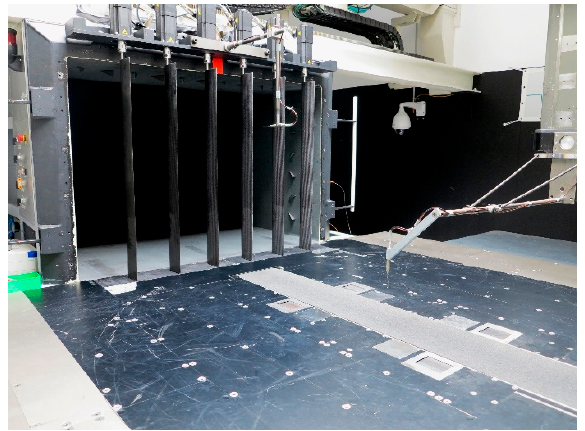
Figure 1. Forschungsinstitut für Kraftfahrwesen und Fahrzeugmotoren Stuttgart (FKFS) swing ® in the Institute of Automotive Engineering Stuttgart (IFS) model scale wind tunnel, with cobra probes measuring flow angles.